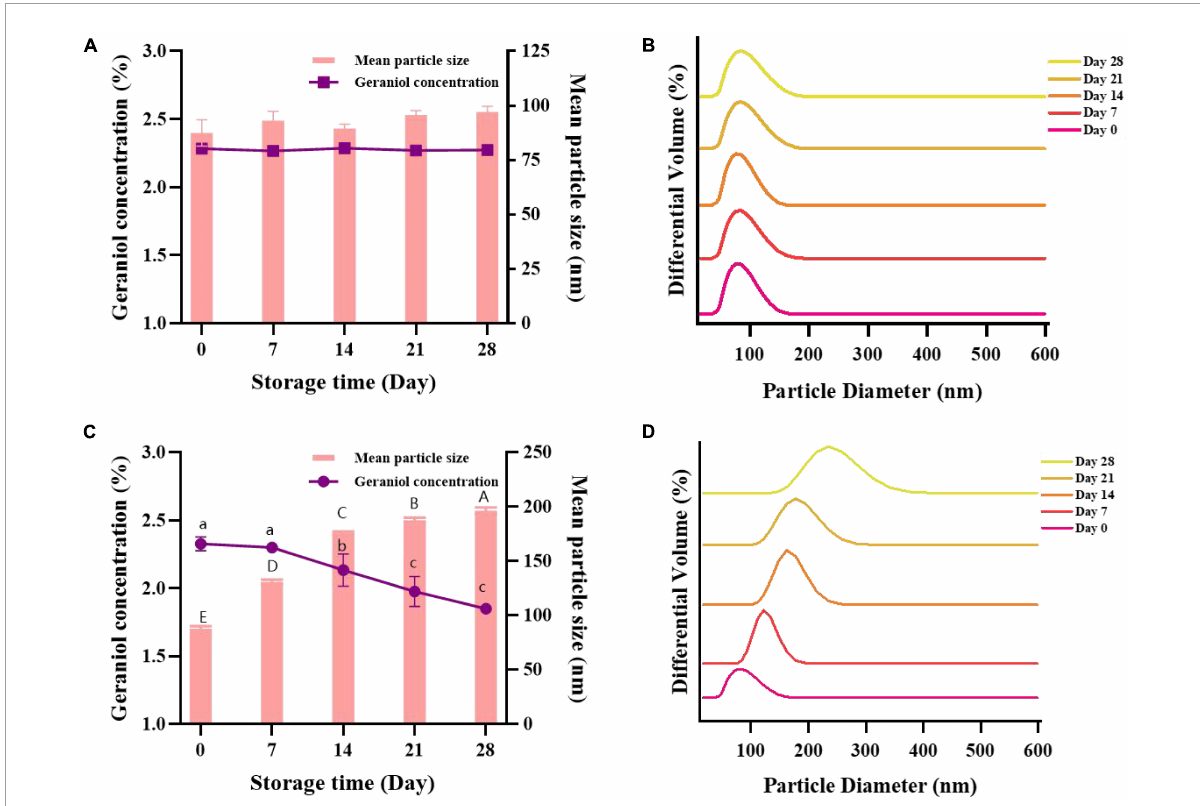
FIGURE5 Effect of long-term storage at 4 ◦ C (A,B) and 25 ◦ C (C,D) on the mean particle size, geraniol content, and particle size distribution of G-NE. (Different capital (lowercase) letters indicate significant intra-group variability, p < 0.05 ; identical capital (lowercase) letters indicate significant inter-group variability, p > 0.05 ).